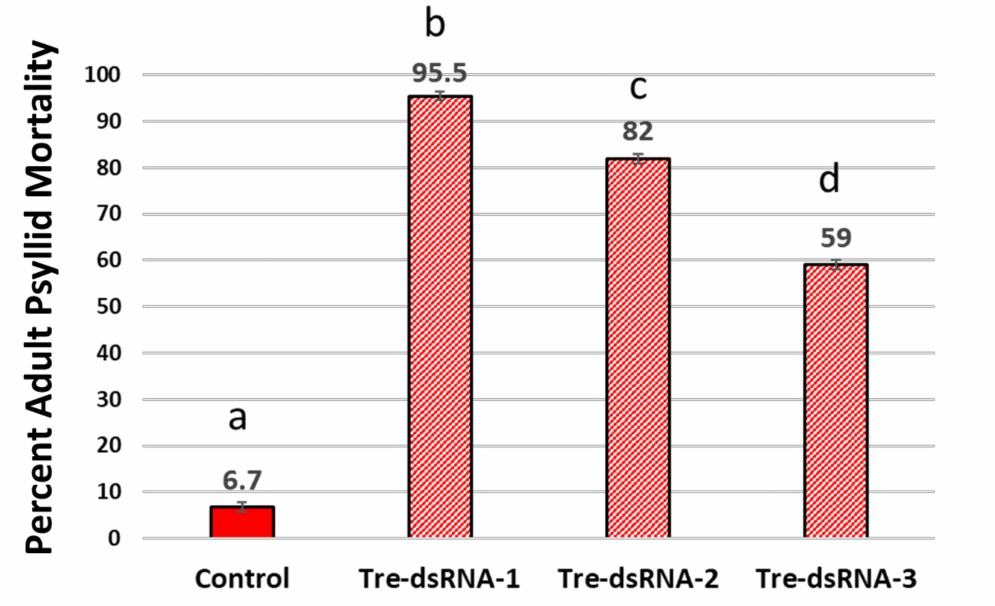
Figure 2. Adult psyllid mortality at 15-d-feeding access on Trehalase -dsRNA treated citrus cuttings. RNAi activity comparison of three dsRNA triggers made to different regions of the soluble Trehalase mRNA in the Asian citrus psyllid. There was statistically significant differences in adult psyllid mortality between group means of treatments as determined with one-way ANOVA ( p < 0.05). Statistical significance of means post-hoc Tukey ( p ≤ 0.01). Error bars represent ± SE of mean (n = 8) calculated on eight biological replicates, with three technical replicates. Experiment repeated twice. Treatments means with the same letters were not significantly